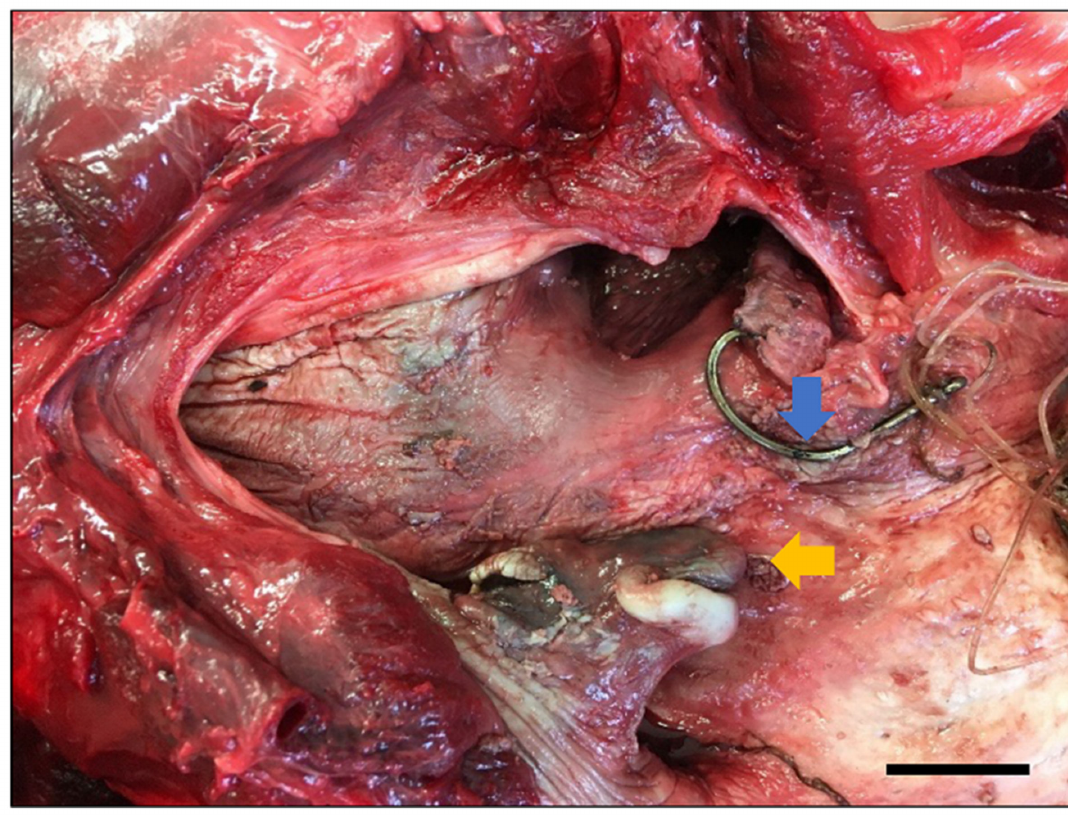
Figure A4. Juvenile female Indo-Pacific bottlenose dolphin ( Tursiops aduncus ) from the Adelaide Dolphin Sanctuary demonstrating hook and line entanglement. A fishhook (blue arrow) was lodged in the laryngeal area of blowhole, causing widespread inflammation. The epiglottis was swollen and discolored (yellow arrow). Scale = 5